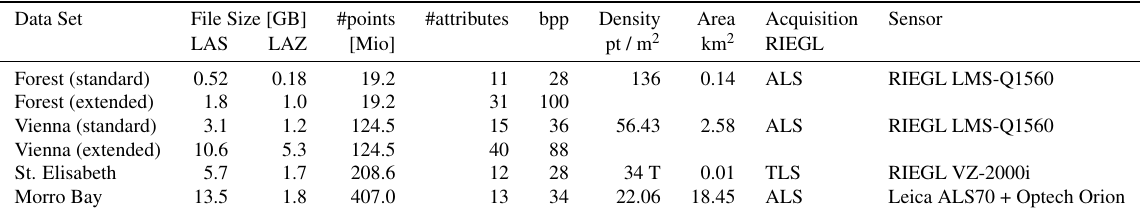
Table 2. Key parameters of used data sets. For data set Forest and Vienna standard and extended attribute sets are available. ALS: Airborne Laser Scanning. TLS: Terrestrial Laser Scanning.